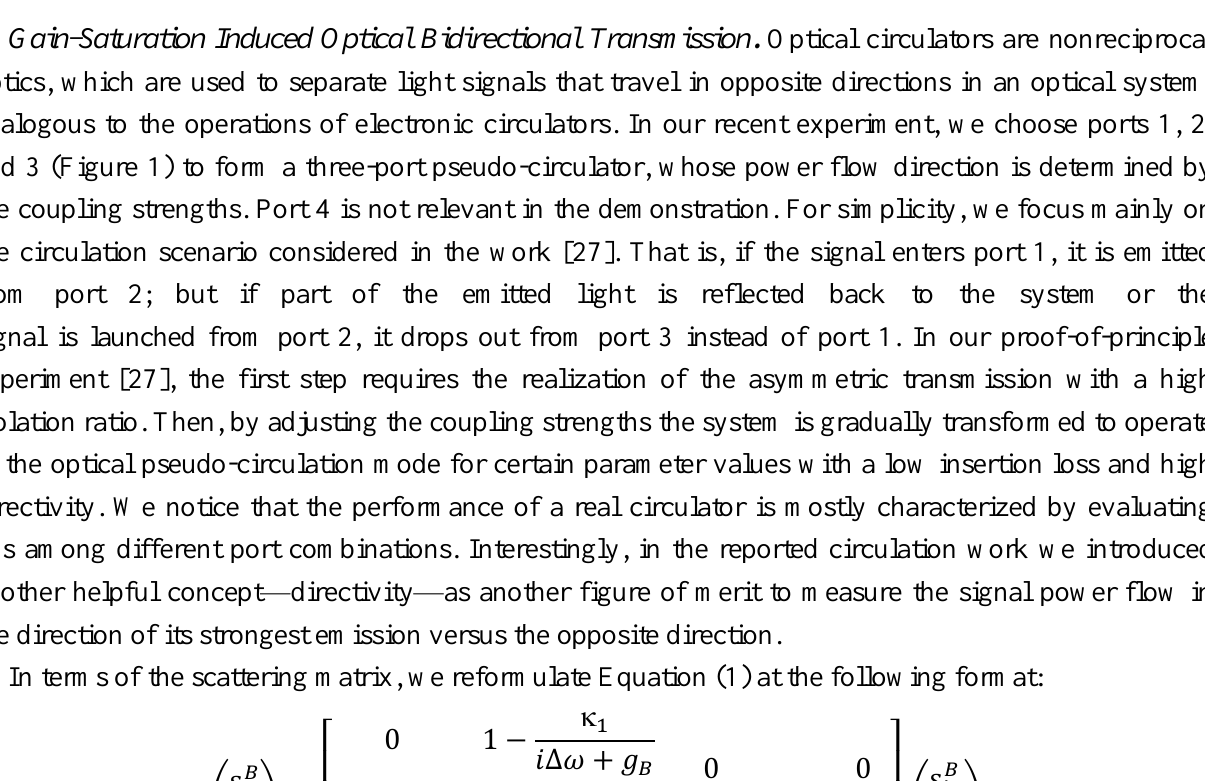
|𝑎 |⁄ √  ⁄ = 2 ) for the  = 0.4 , 𝑔 ≡ 𝑔 𝑖𝑛 𝑠 1 0 1 ⁄ = 0.001 , 𝑔 = 1.3 ) for the blue  2 1 ⁄ = 0.004 ) for the orange line  2 1 1